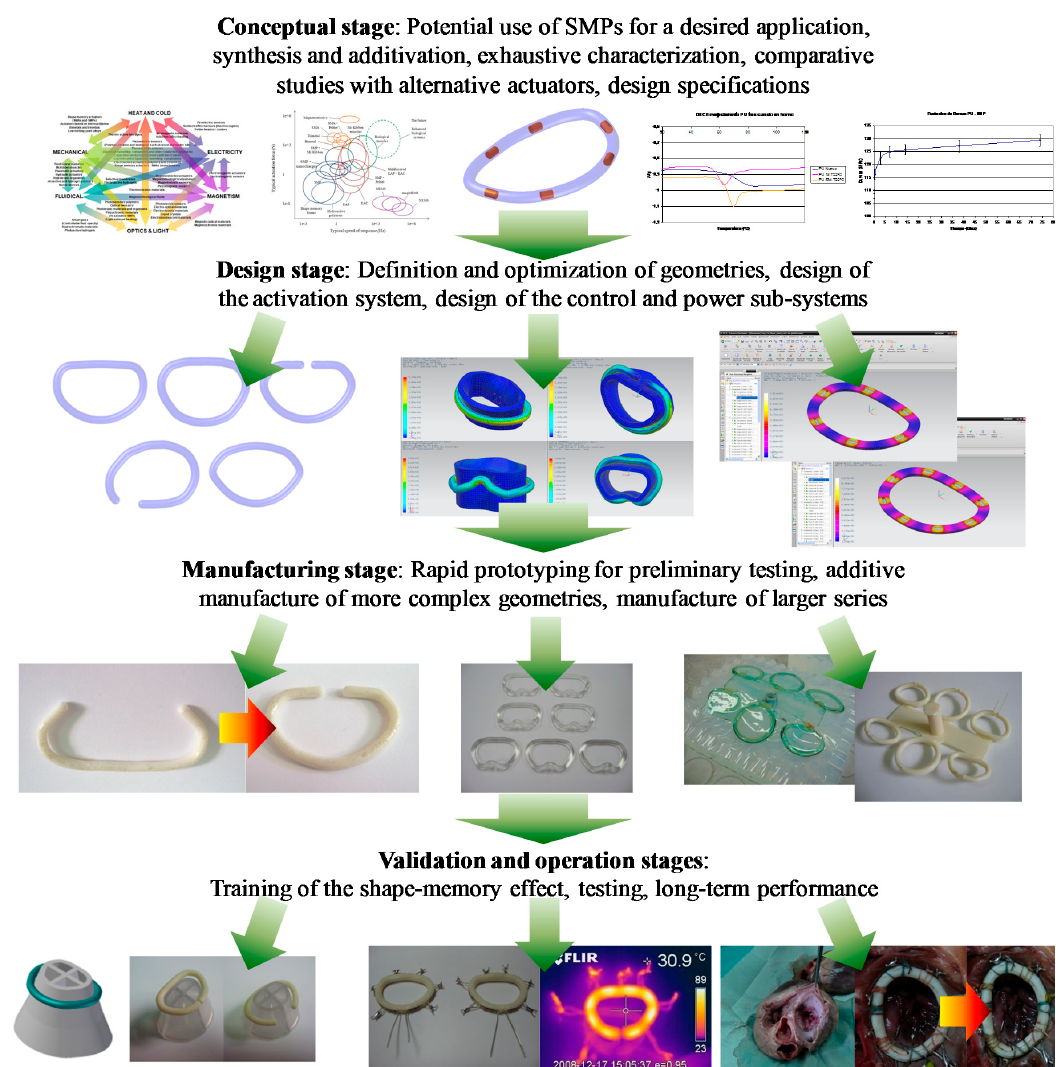
Figure 6. Summary of the complete development process, supported by computer-aided engineering and additive manufacturing approaches, for a “smart” annuloplasty ring based on shape-memory polymers oriented to the potential treatment of mitral valve insufficiency. Adapted from author’s Ph.D. Thesis [10].